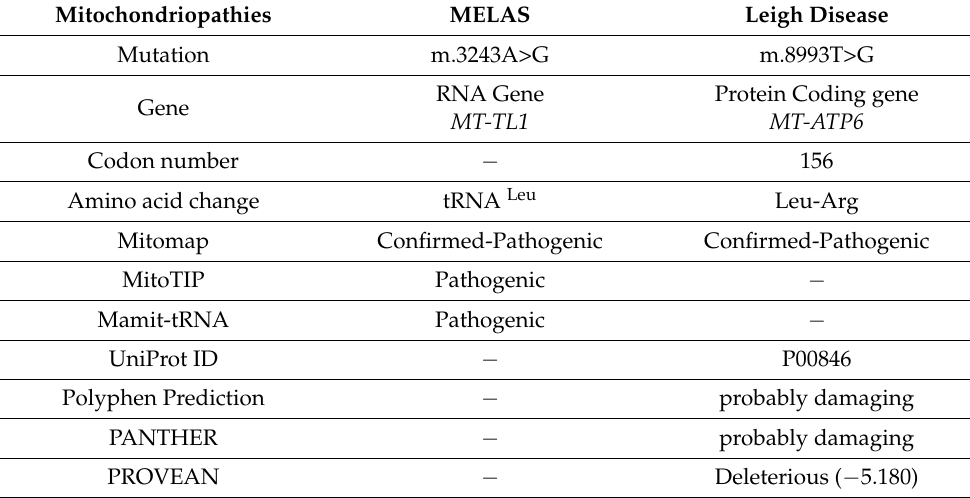
Table 1. Informatics predictors for m.3243A>G and m.8993T>G mutations.